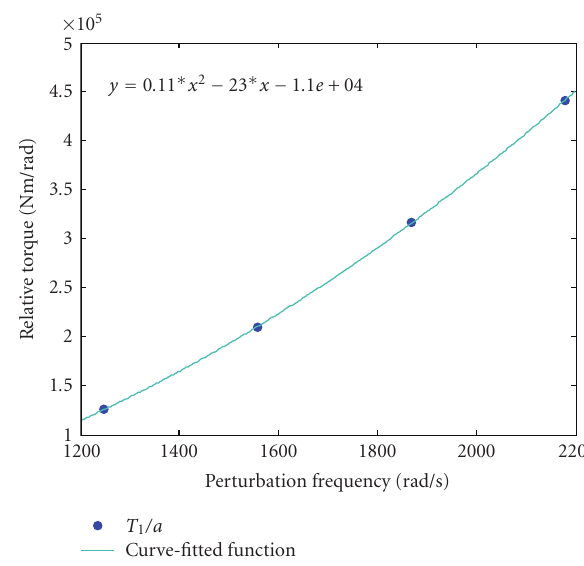
Figure 4: Identification of the coe ffi cients of (17), together with a curve-fitted function (rotational speed is 52rad / s).